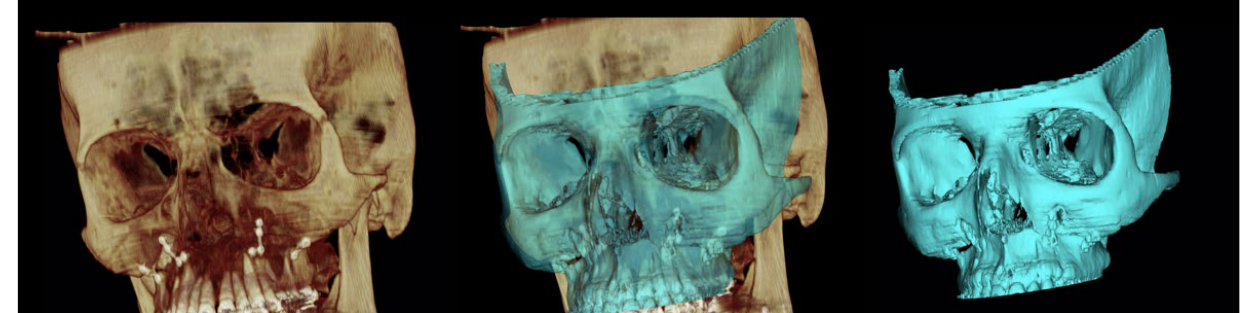
Figure 2. Creation of the STL file starting from the postoperative CBCT.